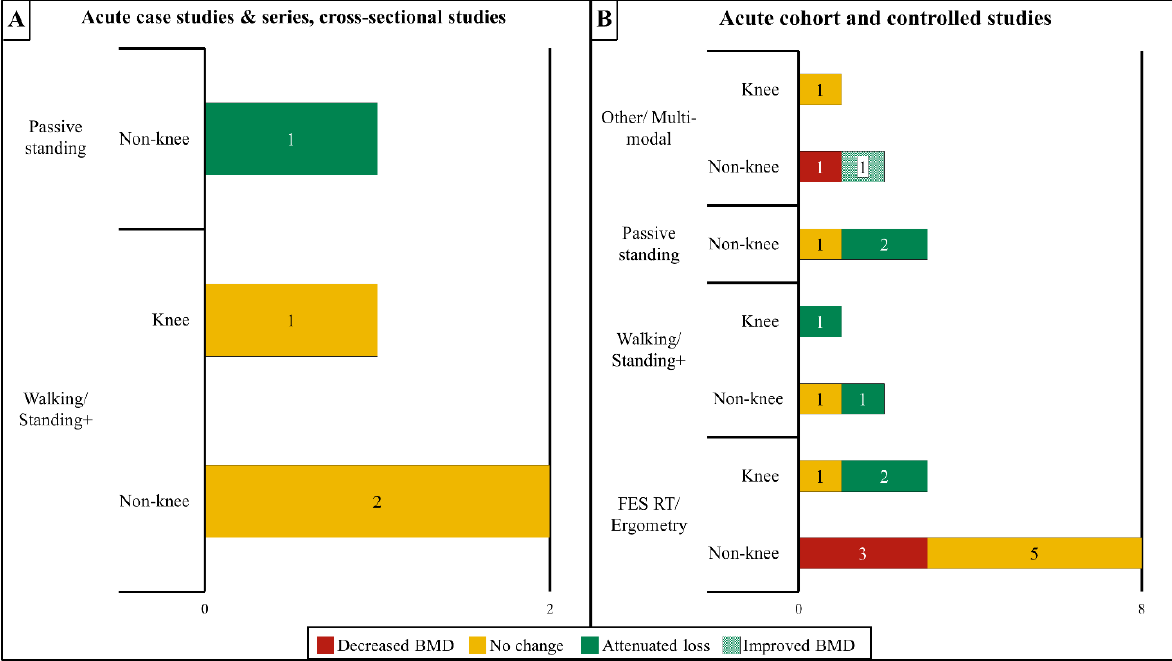
Figure 1. Summary of the effects of activity-based physical therapy (ABPT) on changes in bone mineral density (BMD) at the knee (distal femur and proximal tibia) or all other sublesional non-knee sites in persons with acute/sub-acute SCI for ( A ) case studies, case series, and cross-sectional studies or ( B ) controlled and cohort studies. The total number of studies that reported decreased BMD, no BMD change, attenuated BMD loss, or improved BMD after an ABPT modality are provided in the corresponding bars. Some studies examined both knee and non-knee sites – in these instances, the individual results for knee and non-knee sites were included in each bar. If a study compared more than one modality, the individual results for each modality were included if available. If no studies were found that fit a certain category, the category was omitted from the chart. Overall, most acute studies showed no effect or attenuated BMD loss over time. FES, functional electric stimulation; RT, resistance training; “Standing+” refers to interventions that combined standing modalities with other modalities that increase muscle activation such as FES or vibration.